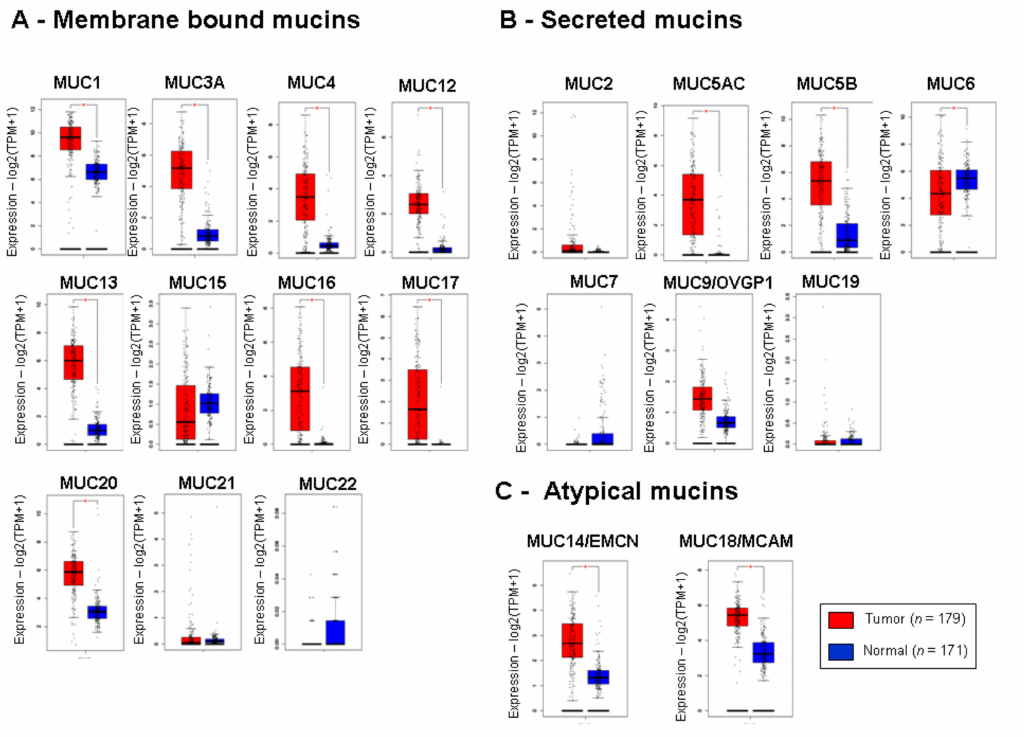
Figure 1. Relative mucin messenger RNA (mRNA) levels in pancreatic adenocarcinoma and normal pancreas tissues. The whisker boxplots for the mRNA of membrane-bound mucins ( MUC1, MUC3, MUC4, MUC12, MUC13, MUC15, MUC16, MUC17, MUC20, MUC2 1, and MUC22 ) ( A ), secreted mucins ( MUC2, MUC5AC, MUC5B, MUC6, MUC7, MUC8, MUC9 / OVGP1, and MUC19 ) ( B ), or atypical mucins ( MUC14 / EMCN, MUC18 / MCAM ) ( C ) were generated using GEPIA in The Cancer Genome Atlas (TCGA) and Genome Tissue Expression (GTEX) samples. Mucin mRNA relative levels are expressed as log 2 transcripts per million bases (TPM). Statistical analyses were performed using an unpaired t -test (* = p <